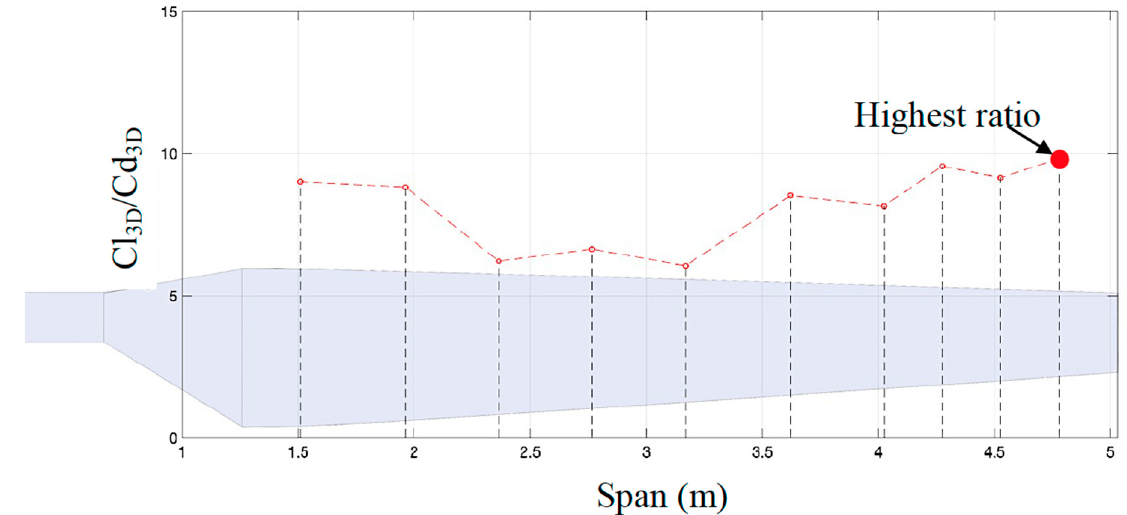
Figure 15. Cl 3D /Cd 3D ratio distribution for the original blade at 10 m/s.